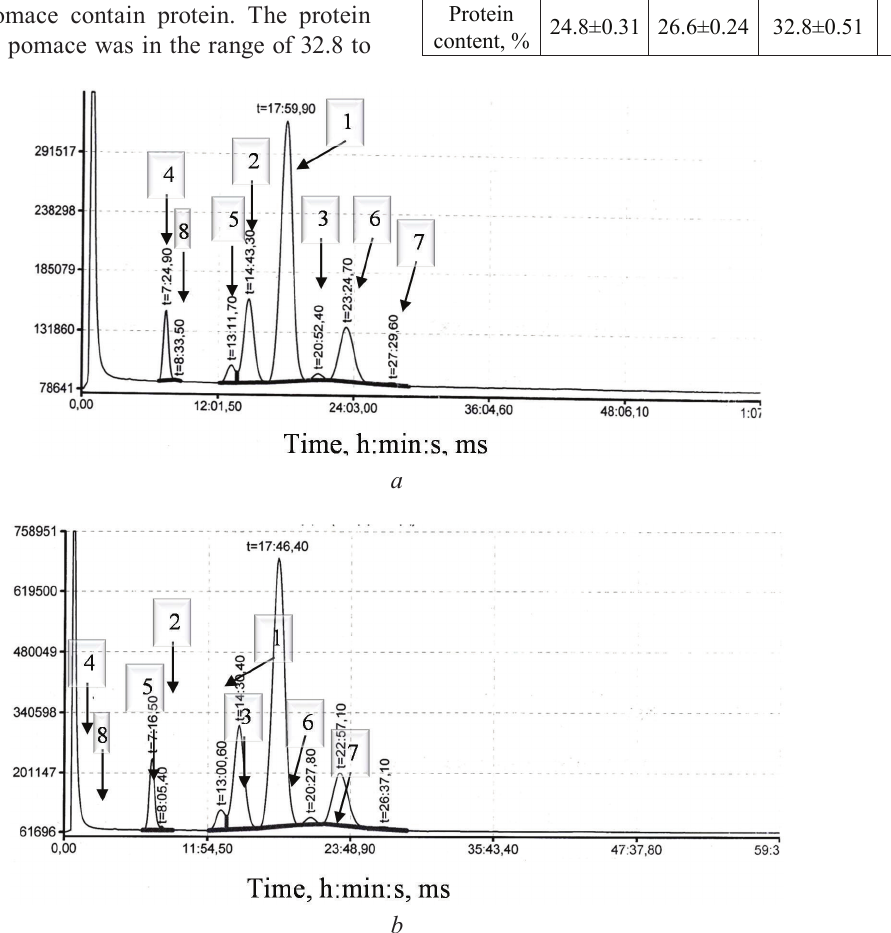
Fig. 2. The chromatogram of hemp oil methyl esters identified using the GC method: a – No. 1, 2019; b – No. 2, 2020; 1 – linoleic acid, 2 – oleic acid, 3 – linolenic acid, 4 – palmitic acid, 5 – stearic acid, 6 – linolenic